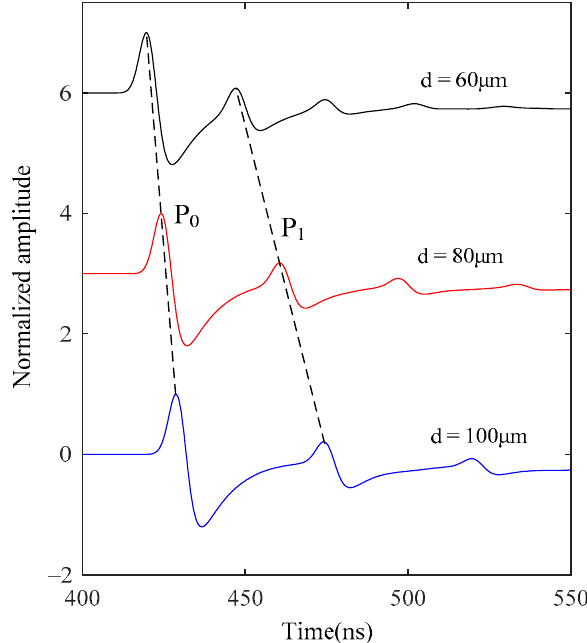
Figure 7. Waveform overlapping caused by thin copper layer.